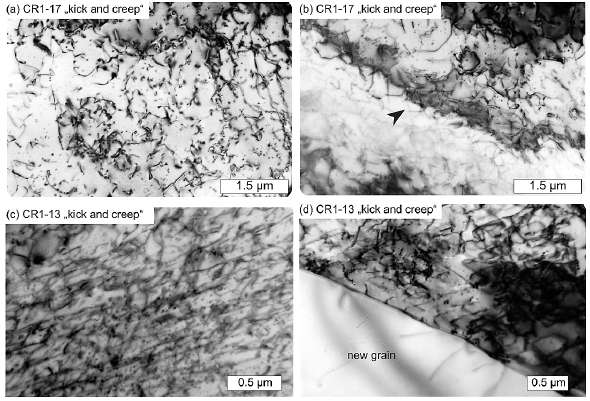
Fig. 9. TEM bright field micrographs of quartz, being exceedingly prone to radiation damage. (a, b) TEM micrographs from FIB cut foils shown in Fig. 6c; “kick and creep” experiment CR1-17 with stress relaxation. Quartz shows dislocation density on the order of 10 12 m − 2 . Poorly ordered dislocation wall in (b) is marked by ar- row. (c) TEM micrograph from FIB cut foil, location shown by yel- low rectangle in Fig. 8b; “kick and creep” experiment CR1-13, with approximately constant stress. Quartz shows high density of dislo- cations arranged in walls parallel to SWUE visible by polarization microscopy. (d) TEM micrograph from FIB cut foil located by red rectangle in Fig. 8b; “kick and creep” experiment CR1-13, with ap- proximately constant stress; high angle grain boundary between de- formed and recrystallized grain with low dislocation density.